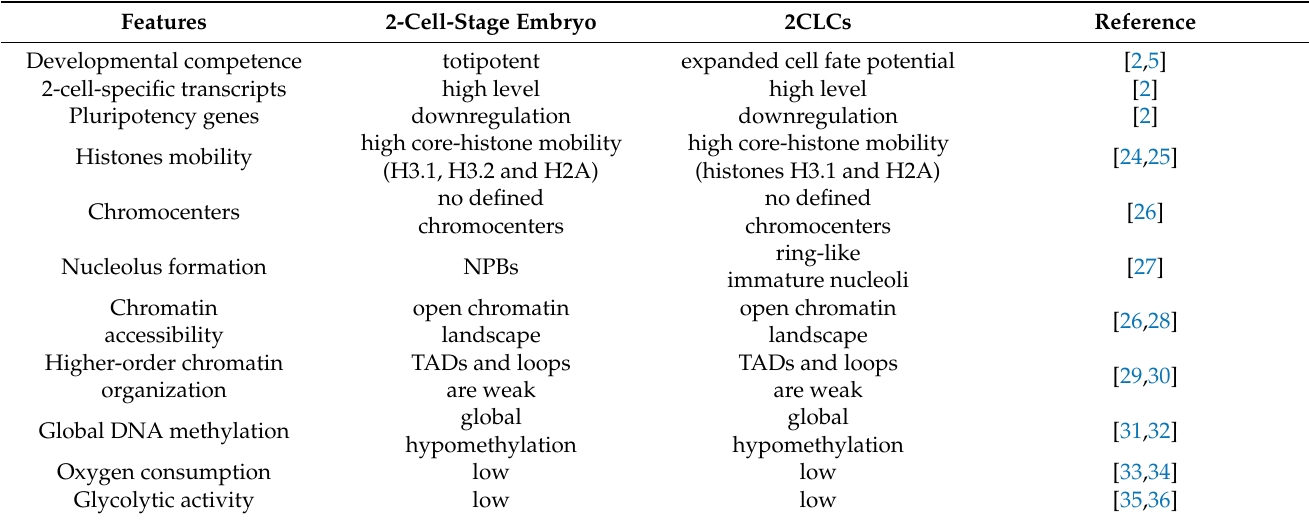
Table 1. Known similar features of 2CLCs as 2-cell-stage